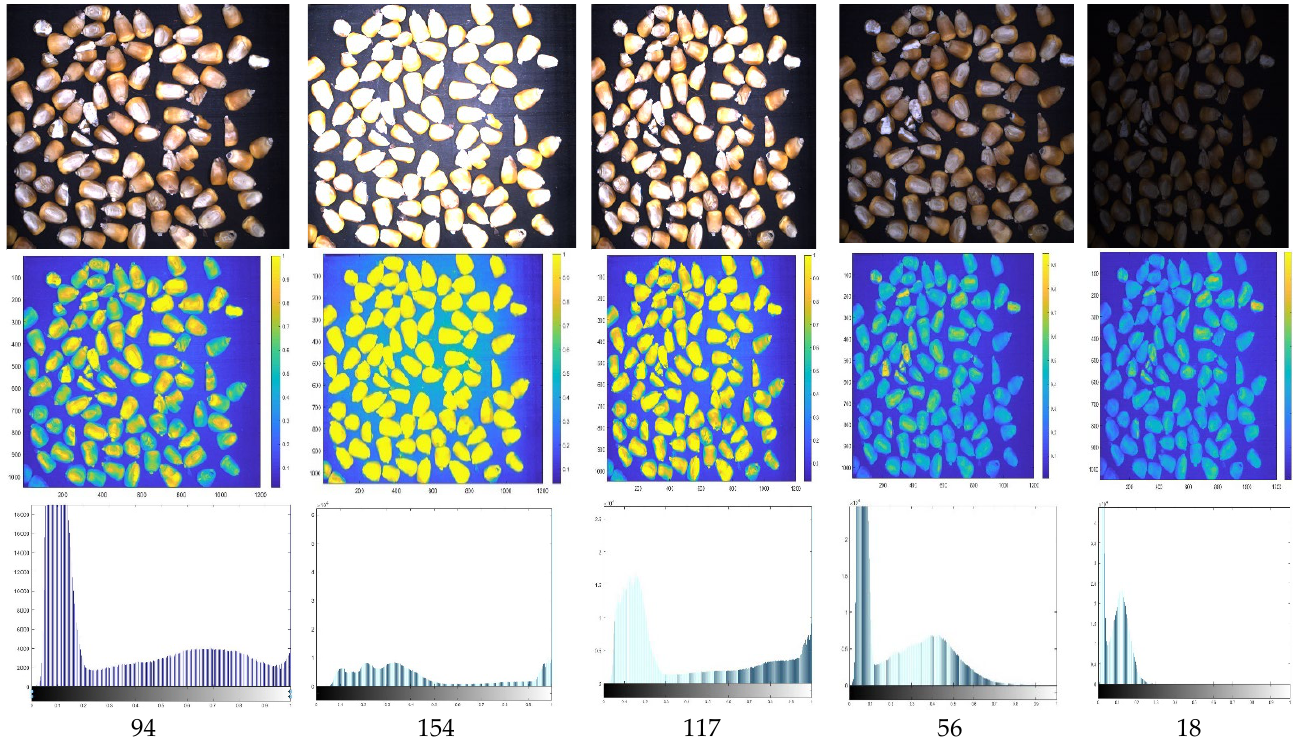
Figure 4. Grain image and grayscale histogram under different brightness conditions. By thresholding the background and the target object, the gray values of the double- type transformation were 0.4, 0.35, 0.3, and 0.25 as the brightness threshold limit and the pixel distribution probability of the brightness value was counted in order to obtain the data that are provided in Table